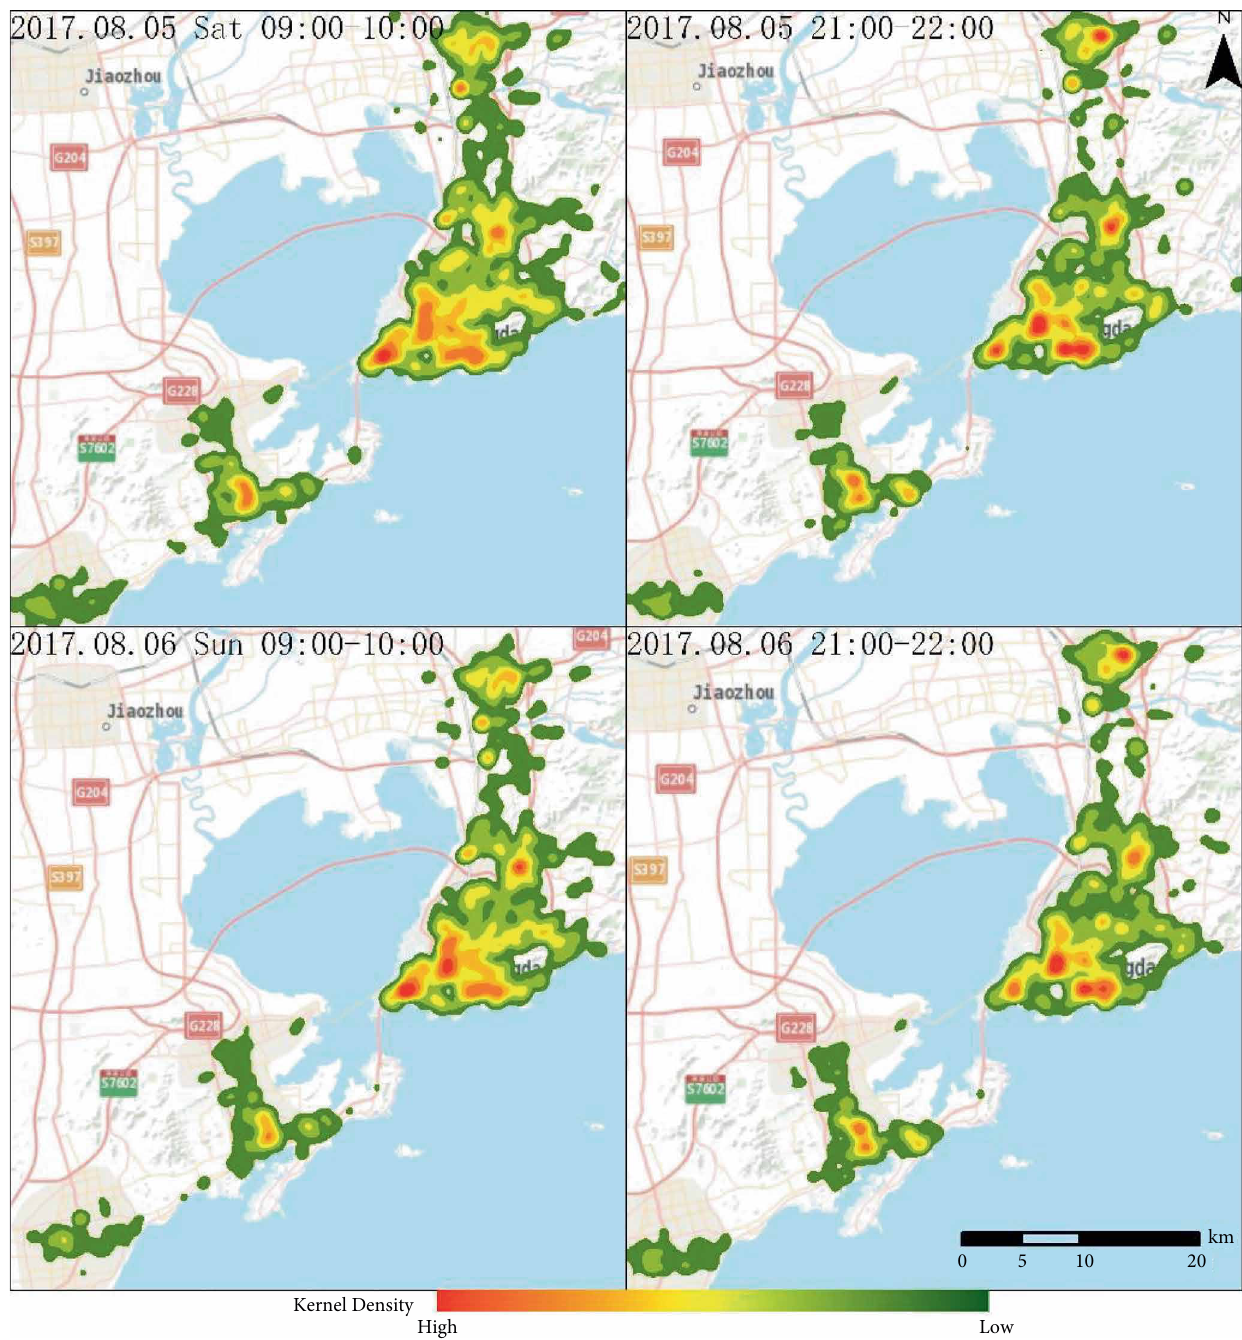
Figure 6: Kernel density of weekends peak